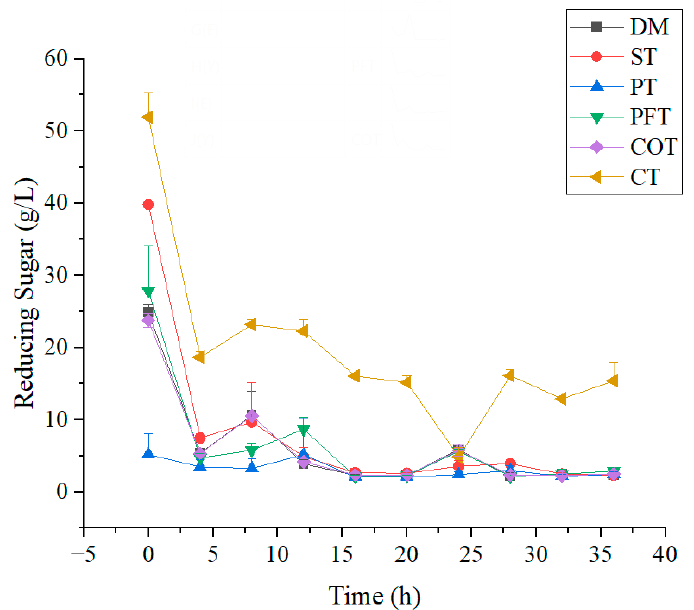
Figure 3. Changes in reducing sugar in culture medium containing molasses with different treatment methods. Molasses with different treatment methods (170 mL/L) was added into culture medium. DM represents untreated molasses. ST, PT, PFT, COT and CT represent sulfuric acid treatment process, phosphoric acid treatment process, potassium ferrocyanide treatment process, calcium phosphate tribasic treatment process, combinational treatment process, respectively. Data were obtained from triplicate tests and shown as mean ± SD.